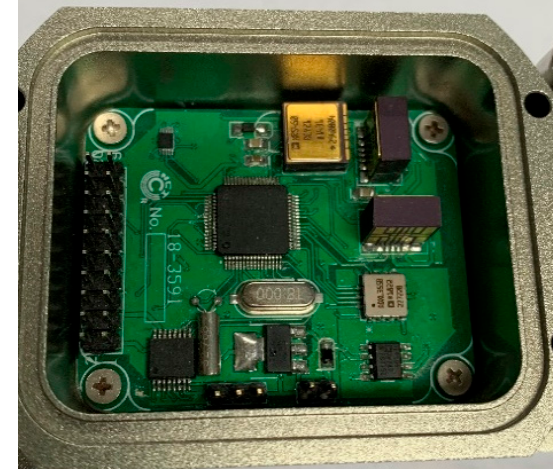
Figure 1. Inertial measurement sensor.